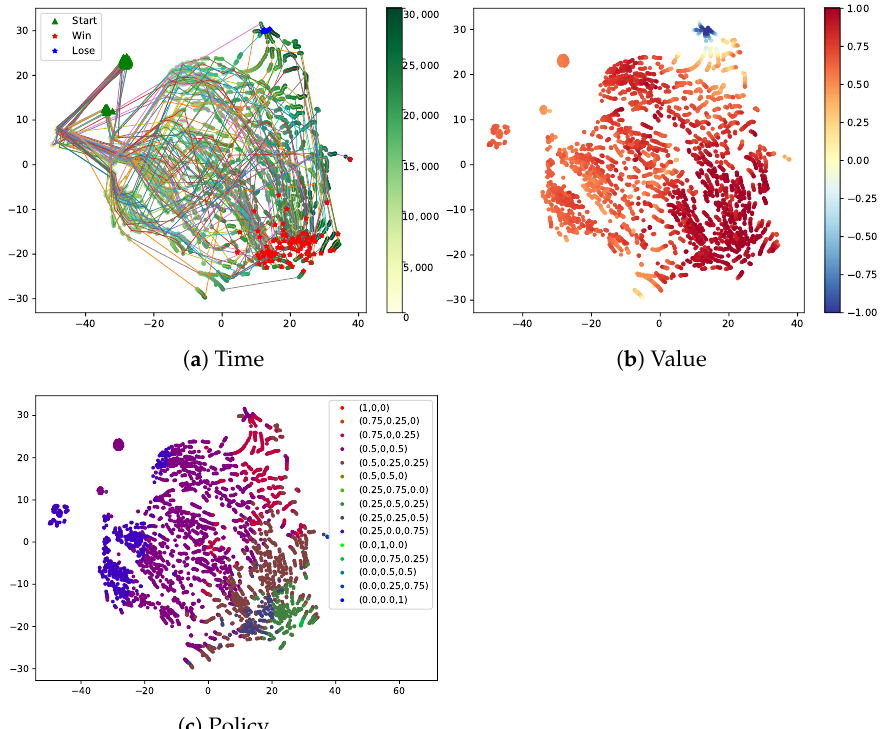
Figure 5. The t-SNE figures of the states that are generated by the learned policy in 100 matches. The opponent bot, Steamhammer, uses the opening strategy of 11Rax. The states are colored based on time, value, and policy, respectively (Best viewed with zoom). ( a ): The states of the beginning, the winning end, and the losing end are marked as green triangles, red asterisks, and blue asterisks, respectively. Other states are masked as green points, and they are colored based on the times according to them. The points in the same match are connected with thin lines. ( b ): The states are colored based on the value for them evaluated by the learned value network. The value estimations roughly fit the real outcomes of the matches. ( c ): The states are colored based on the action selection probability for them computed by the learned policy network. These probabilities are divided into 15 classes depending on which basic probability vector is the closest. The 15 basic probability vectors are shown in the upper right. In the most cases, the trained agent tends to mainly produce Mutalisk in the early stage, produce Mutalisk and Zergling equitably in the middle stage, and produce each unit equitably in the final